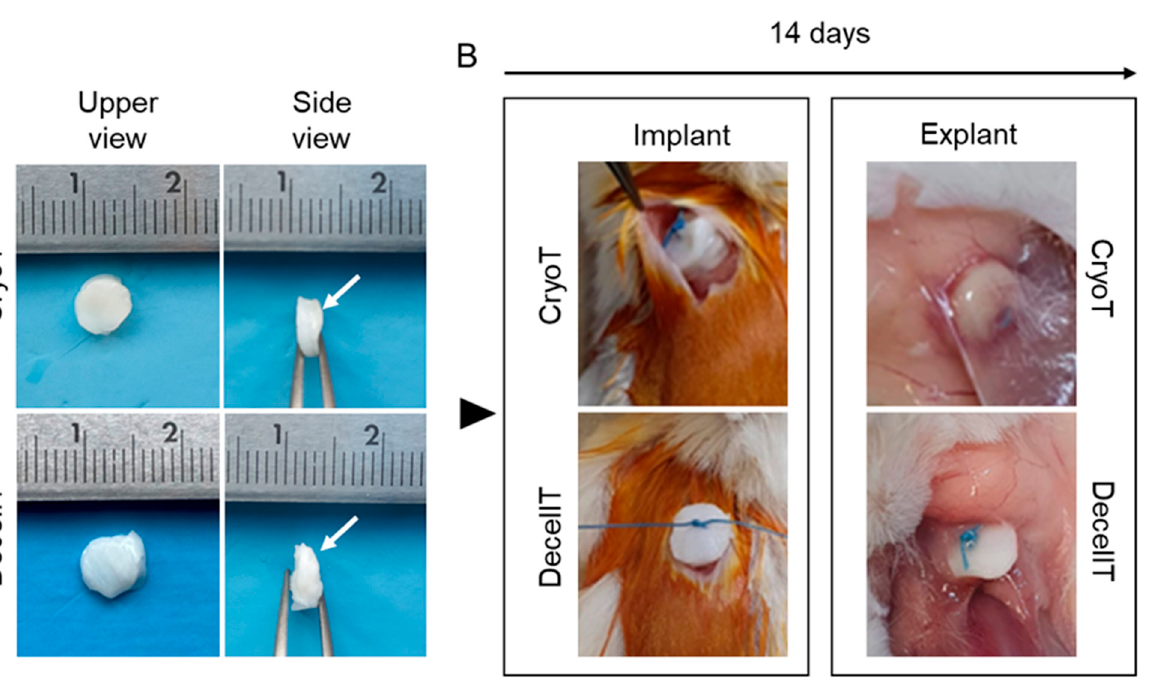
Figure 13. Gross appearance of cryopreserved (CryoT) and decellularized (DecellT) trachea samples before implant (the white arrows show the mucosa side) ( A ), after in vivo positioning in Balb/C mice (subcutaneous dorsal pouch) and at retrieval (14 days from surgery) ( B ). The mucosa side was placed in contact with the latissimus dorsi .